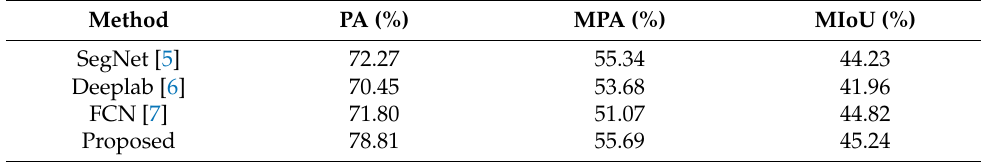
Table 6. The overall experimental results in our